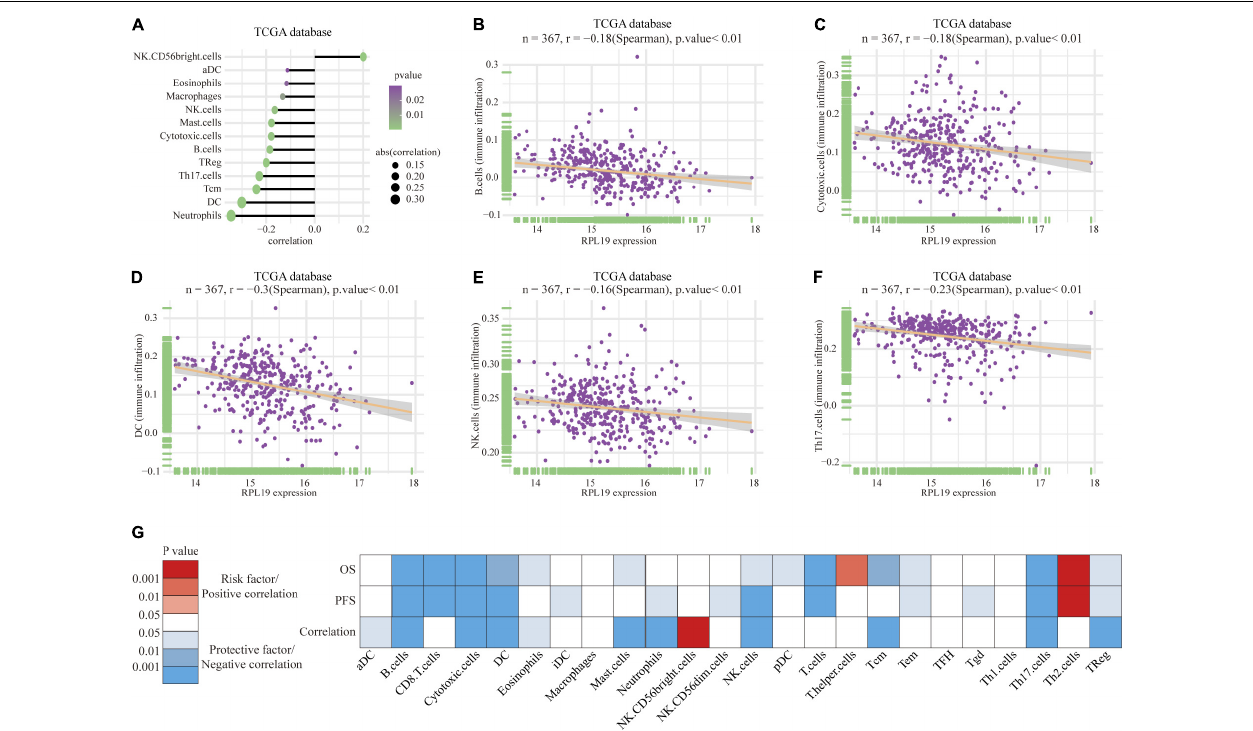
FIGURE 7 | Immune infiltration analysis of RPL19. (A–F) Correlation between immune cells and the expression of RPL19, including B cells, Cytotoxic cells, DC, NK cells, and Th17 cells. (G) The heatmap of the correlation between OS, PFS and the expression of RPL19. In this section, TCGA database was used for analysis. Spearman’s correlation test was used to evaluate the correlation between the expression level of RPL19 and immune cells. DC, dendritic cells; NK cells, natural killer cells; OS, overall survival; PFS, progress free